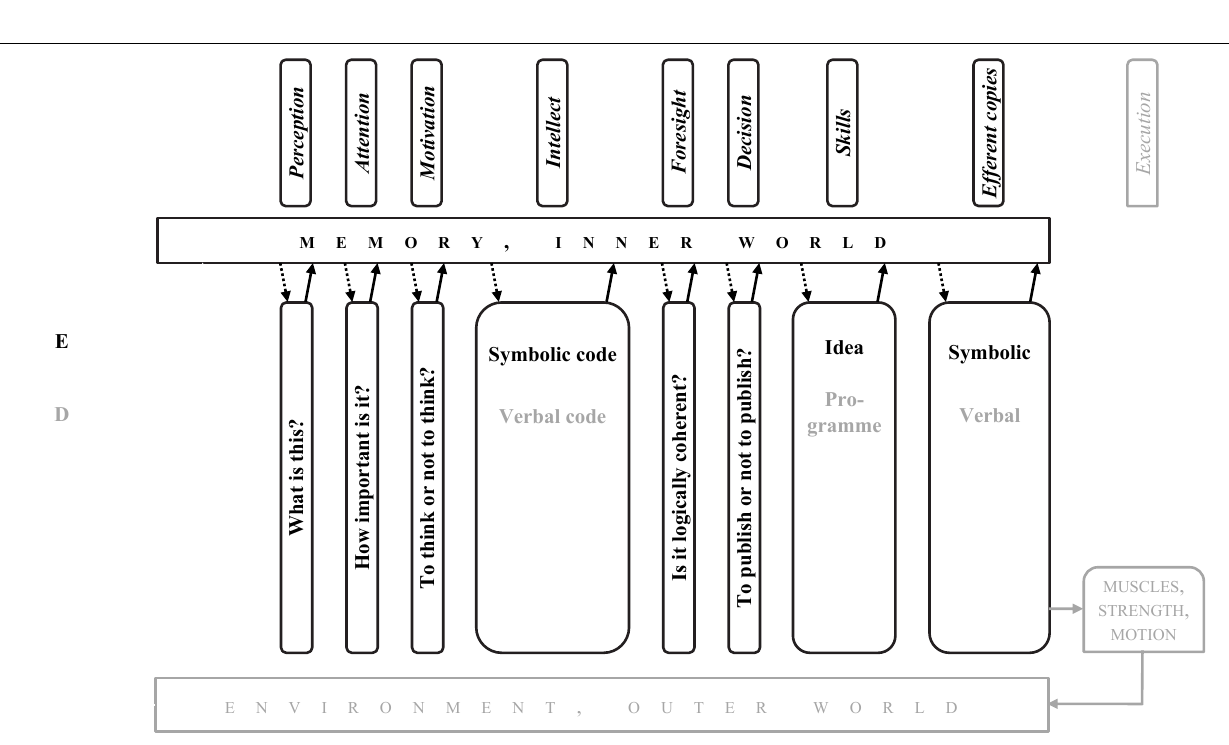
FIGURE 6 | Information processing while creating an abstract mathematical construct. Even if mainly the E-rung works, the movement at A-rung is necessary to transfer the results of processing to the environment.